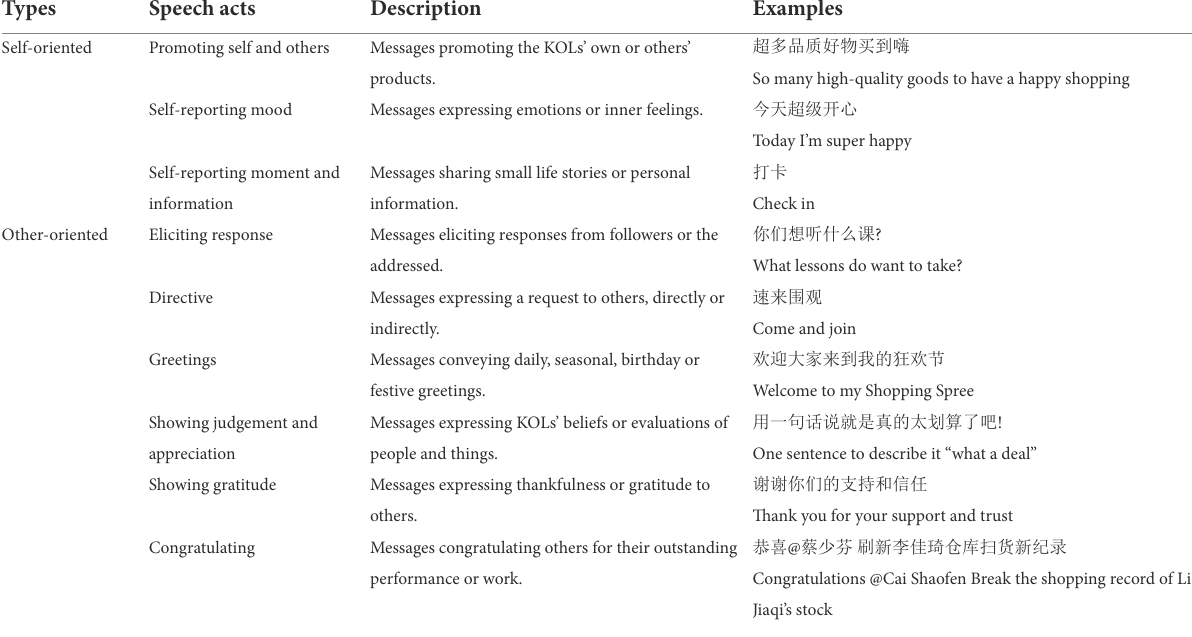
TABLE 3 Illustrative examples for speech acts.